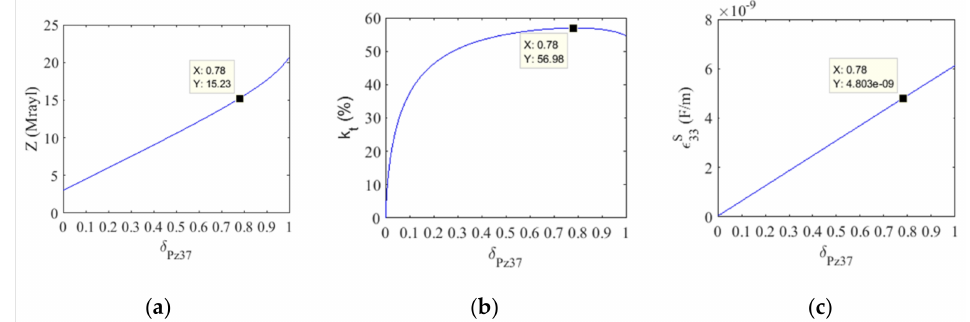
Figure 4. 1–3 piezocomposite material parameters versus Pz37 volume fraction: ( a ) acoustic impedance, ( b ) electromechani- cal coupling, ( c ) dielectric permittivity. The points on the curves indicate the property values for the 78% volume